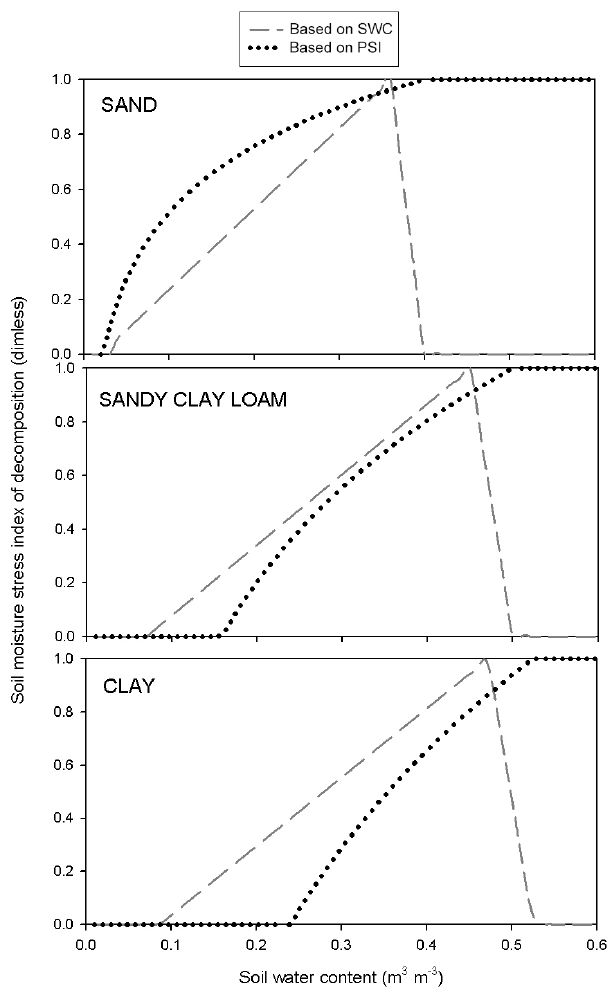
Figure 4. Soil moisture stress index used by decomposition for three different soil types: sand (a) , sandy clay soil (b) , and clay (c) . Soil stress index based on soil water potential (dotted lines) is used by the original model, while soil stress index based on soil water content is used by BBGCMuSo (dashed grey